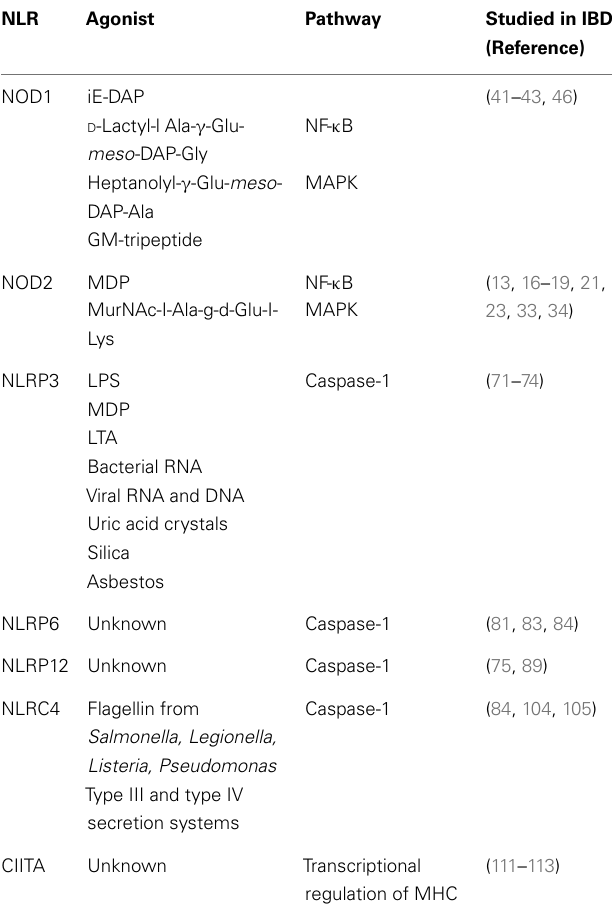
Table 1 | NLR family members studied in IBD